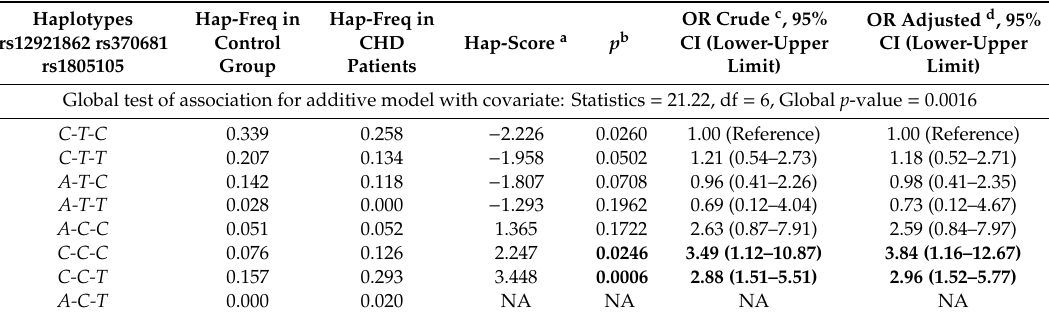
Table 3. Haplotype results for association of AXIN1 gene with CHD risk.